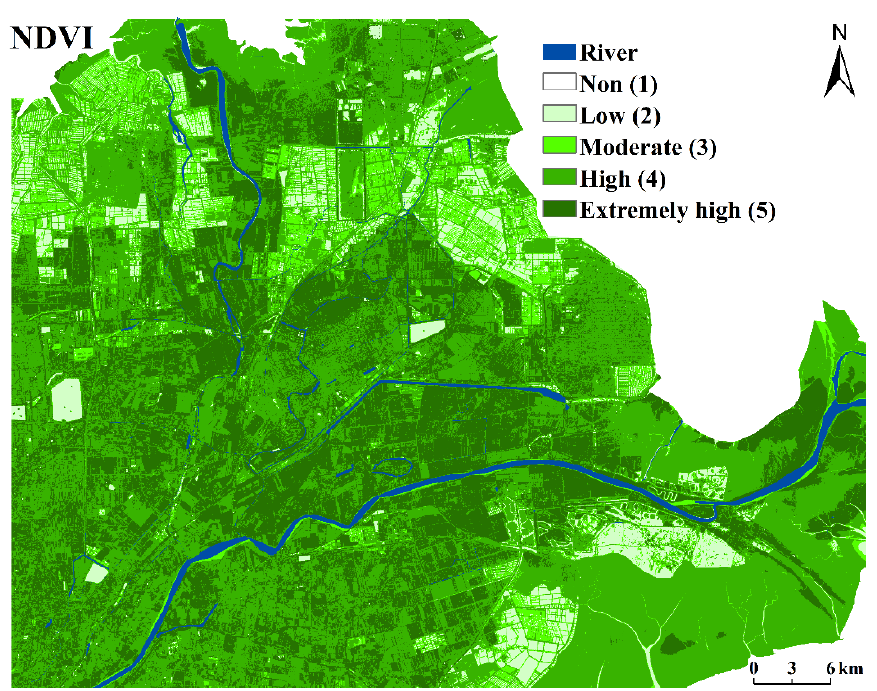
Figure 3. The spatial distribution of NDVI in the study area.